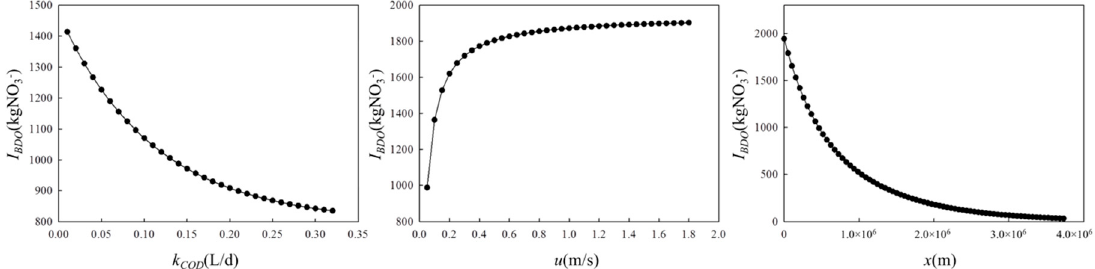
Figure 1. Characterization results for BDO impact category in response to the change of single factor including k COD , x , and u (1DCCM).